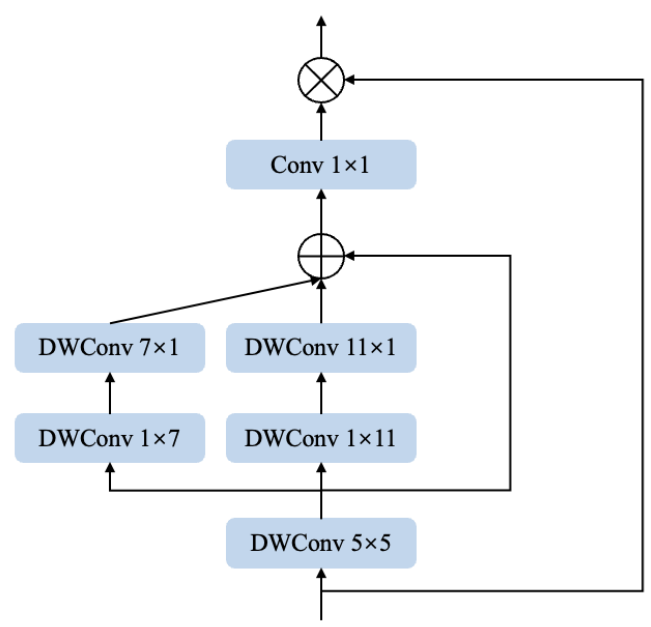
Figure 4. Strip depthwise convolutional attention module.